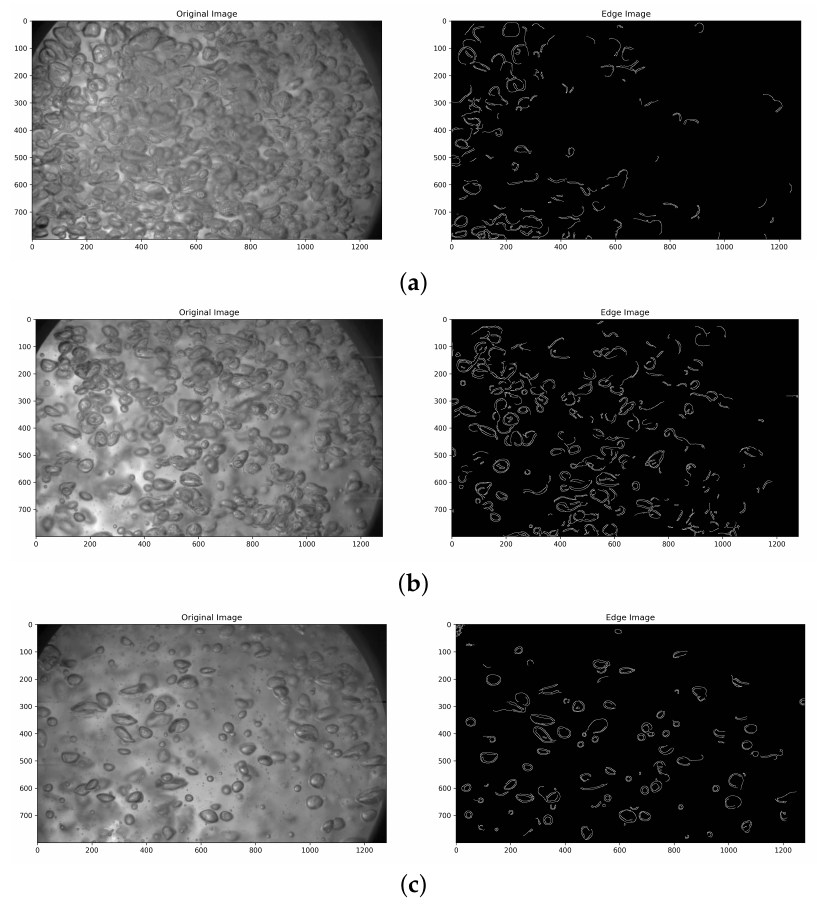
Figure 5. Examples of the final edge detection method on ( a ) F1, ( b ) F2, ( c ) F3 video sample frames. One can see that due to a high density of the image objects the method finally fails to detect bub- bles